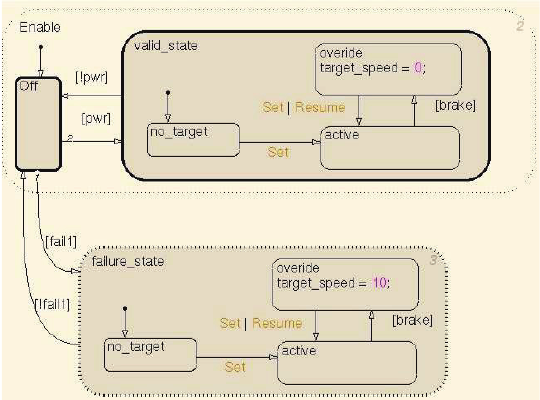
Fig. 8. Simulink Stateflow model (including failure) active proctype nondeterm(){ mtype event;